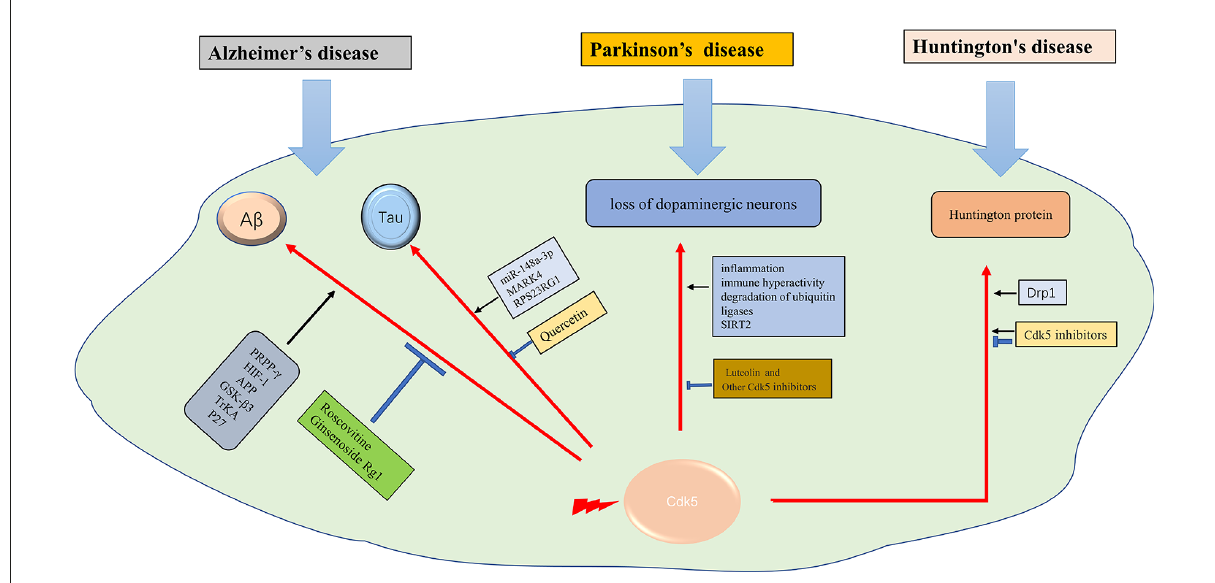
FIGURE2 The role of Cdk5 in neurodegenerative diseases. → : promote or aggravate; (cid:97) : inhibit or